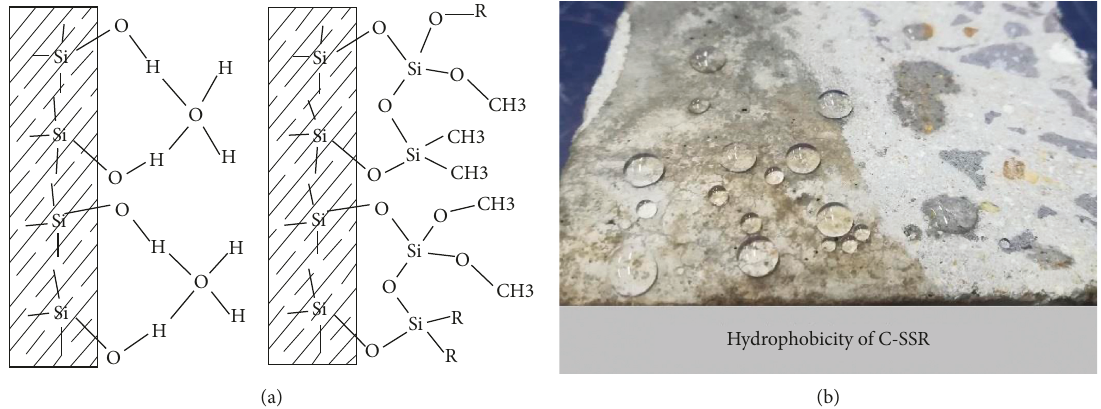
Figure 7: SR reaction mechanism leading to concrete hydrophobisation.